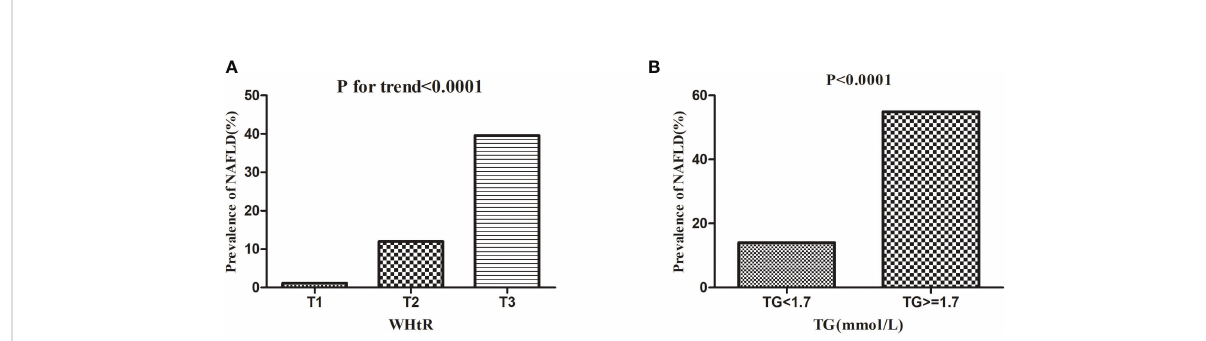
FIGURE 4 Prevalence rate of NAFLD according to the TG groups and WHtR tertiles. Figure 4 (A) showed that the prevalence of NAFLD increased as the WHtR group grew, and the trend test was statistically signi fi cant (P < 0.0001 for trend). Figure 4 (B) showed that the prevalence of NAFLD was signi fi cantly higher in those with hypertriglyceridemia than those without hypertriglyceridemia (P < 0.0001).